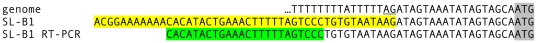
RNA from the pHyVec7 transgene is trans-spliced.RNA from the operon transgenic line was reverse-transcribed to produce first strand cDNA. The cDNA was amplified with primers for the spliced leader SL-B1 and the DsRed2 coding sequence. The top line shows sequence between the RFC140 and flp genes extending from the polypyrimidine tract associated with the trans-splicing AG acceptor dinucleotide (doubly underlined) to the start codon of the flp gene (shaded in gray). The second line shows the sequence from a previously identified flp EST containing the SL-B1 spliced leader sequence [13]; the spliced leader sequence is highlighted in yellow, and the flp start codon is shaded. The third line shows sequence from the RT-PCR product obtained from the pHyVec7 transgenic line using SL-B1 and DsRed2 primers. The sequence corresponding to the SL-B1 primer is highlighted in green, and the DsRed2 start codon is shaded.